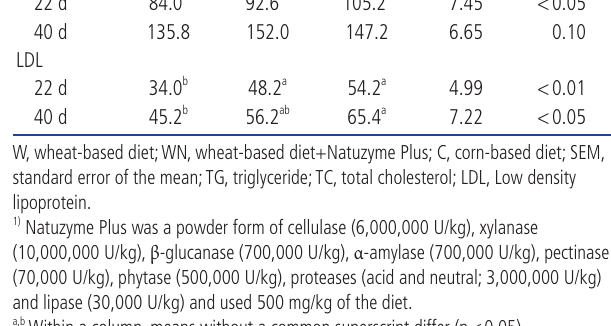
Table 5. There was no significant difference (p>0.05) of the RW Table 6. Effect of Natuzyme Plus 1) inclusion in wheat-based diet on blood lipid Table 5. Effect of Natuzyme Plus 1) inclusion in wheat-based diet on the relative weight (% live BW) of carcass, breast, thigh+drumstick, heart, liver, pancreas, abdominal fat pad in broiler chickens W WN C